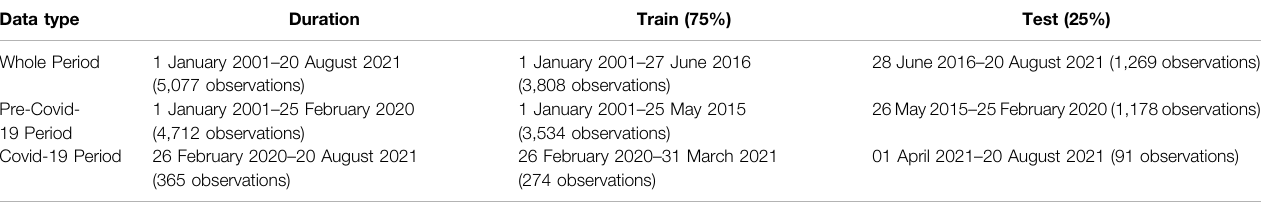
TABLE 1 | Time frame, sample composition, and number of observations.